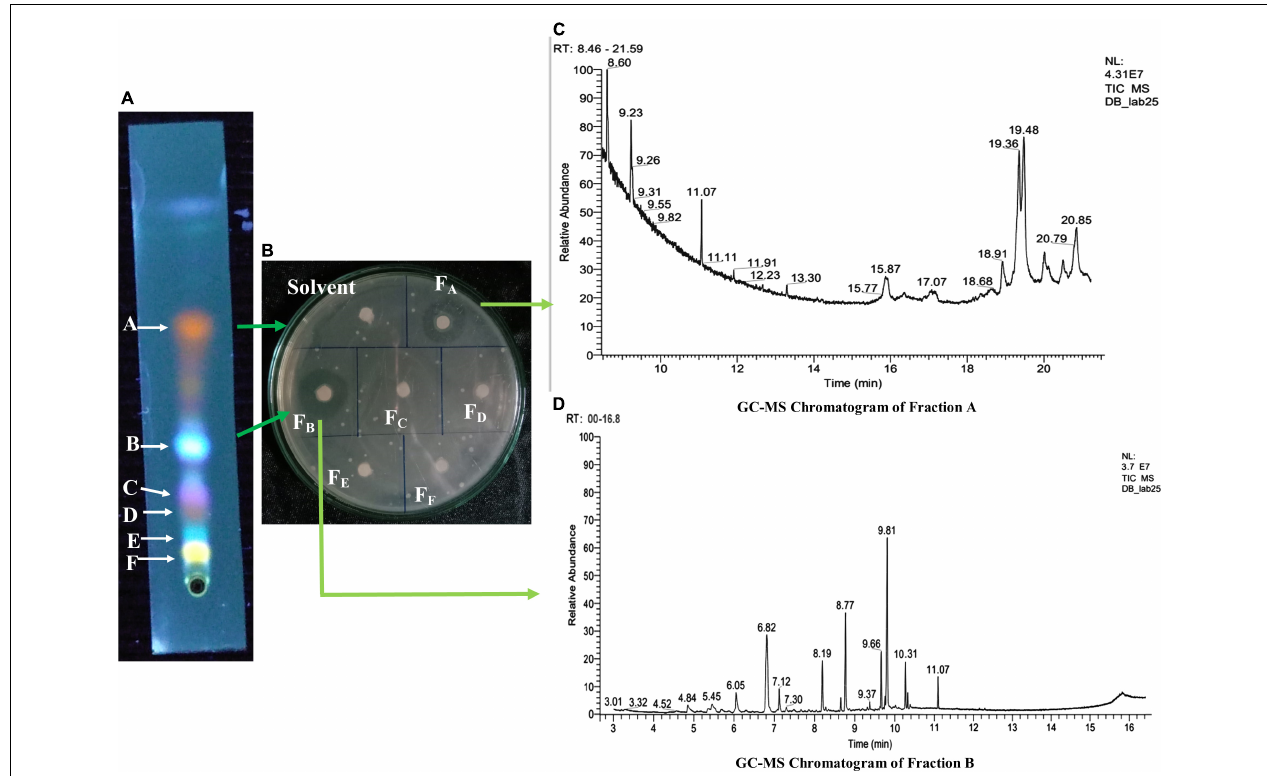
FIGURE 6 | (A) Thin-layer chromatographic (TLC) analysis of EA fraction of HelS1. (B) Zones of inhibition produced by bioactive compounds present in fractions (F A –F F ) obtained from a TLC plate against pathogenic bacteria-MRSA. (C) GC-MS chromatogram of Fraction A showing the peaks of bioactive compounds. (D) GC-MS chromatogram of Fraction B, showing the peaks of bioactive